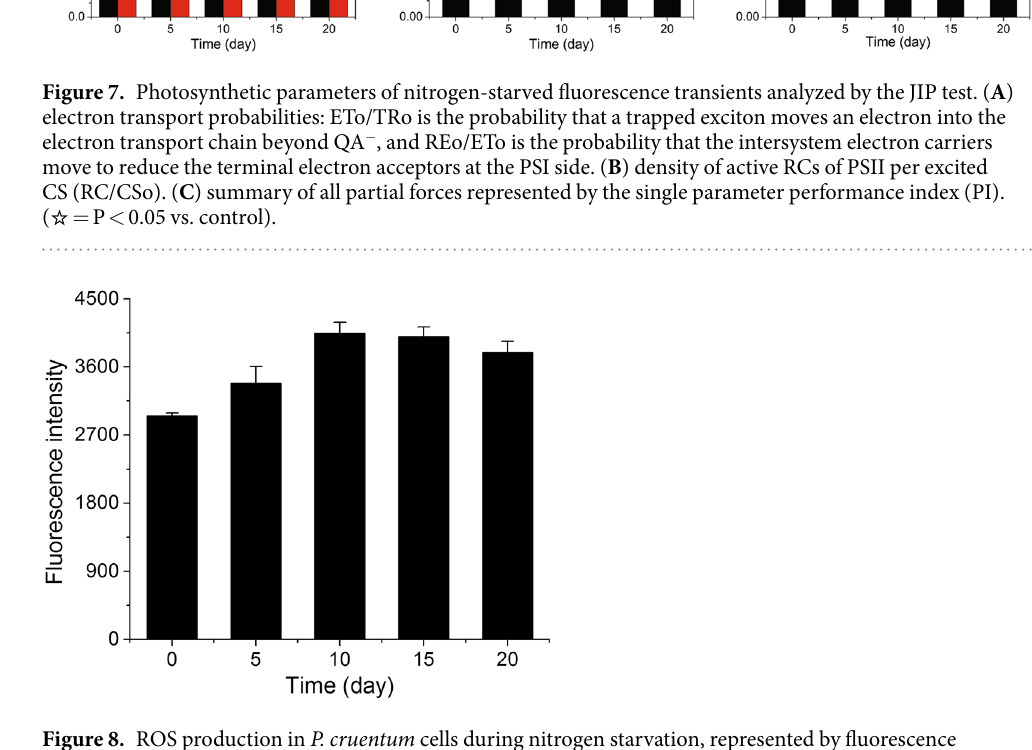
Figure 8. ROS production in P. cruentum cells during nitrogen starvation, represented by fluorescence